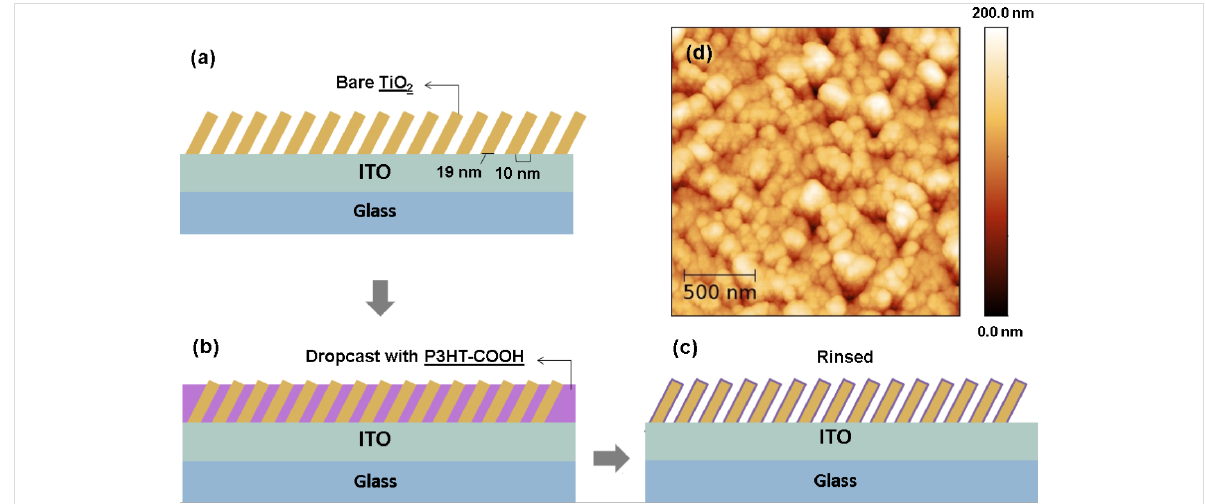
Figure 1: (a–c) Schematic representation of the TiO 2 /P3HT-COOH HHJ preparation. (d) 2 × 2 µm 2 TM-AFM height image of a bare nanocolumnar TiO 2